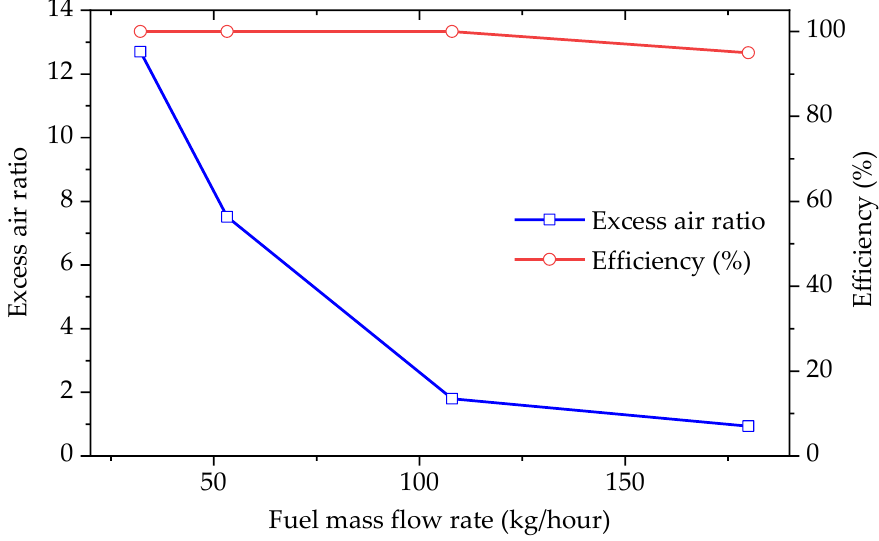
Figure 11. Excess air ratio and efficiency at different fuel mass flow rates.